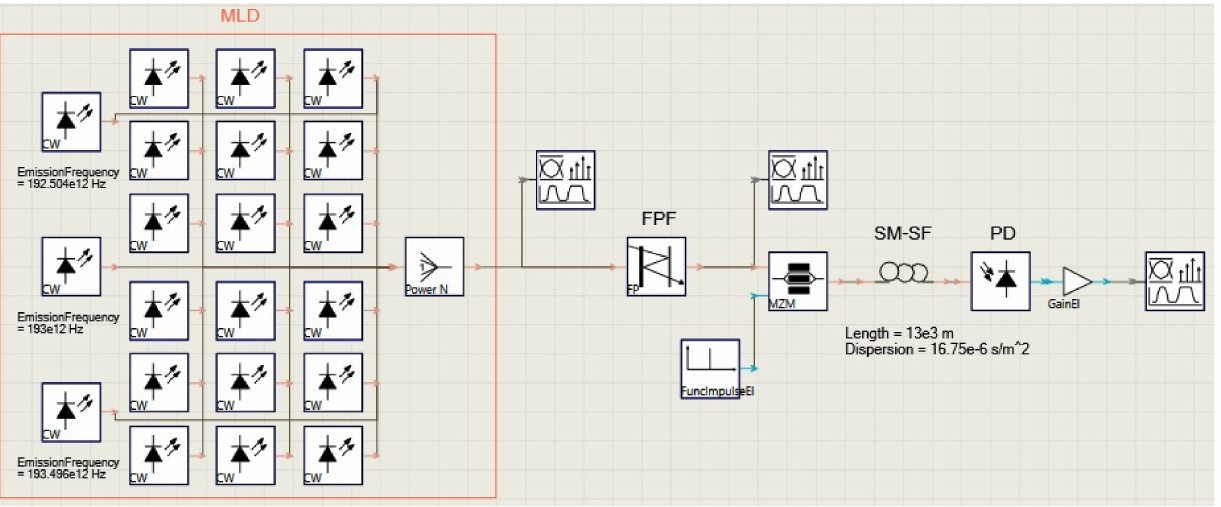
Figure 6. Layout of the simulated MPF in VPIphotonics software where a tunable FPF has been placed to modify the δλ parameter.